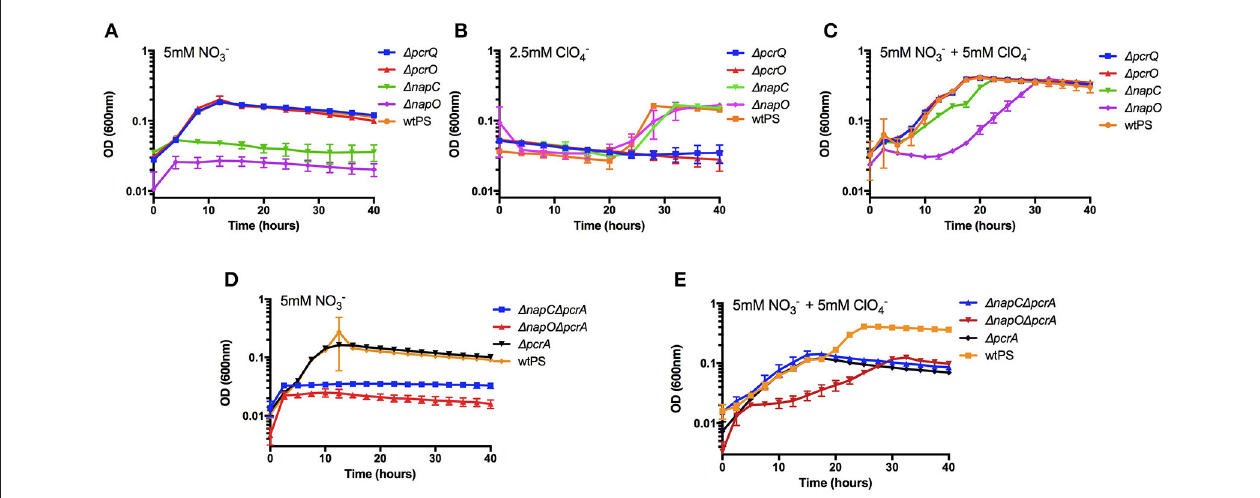
FIGURE 2 | Growth of wtPS, ∆ pcrQ , ∆ napC , ∆ pcrO , and ∆ napO in LMM medium containing nitrate (A) , perchlorate (B) , both nitrate and perchlorate (C) . Growth of wtPS, ∆ pcrA, ∆ napC ∆ pcrA, and ∆ pcrO ∆ pcrA in LMM medium containing nitrate (D) , and both nitrate and perchlorate (E) . Error bars represent standard deviations of biological triplicate